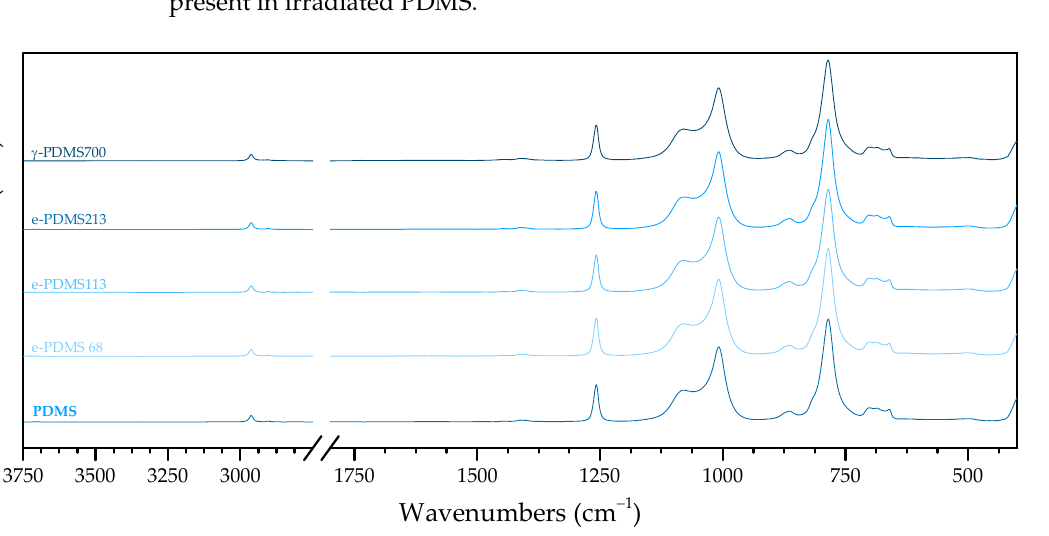
Figure 4 confirms that irradiated PDMS shows the typical fingerprint of pristine PDMS, with minimal differences between samples, being that all bands present in PDMS are also present in irradiated PDMS.